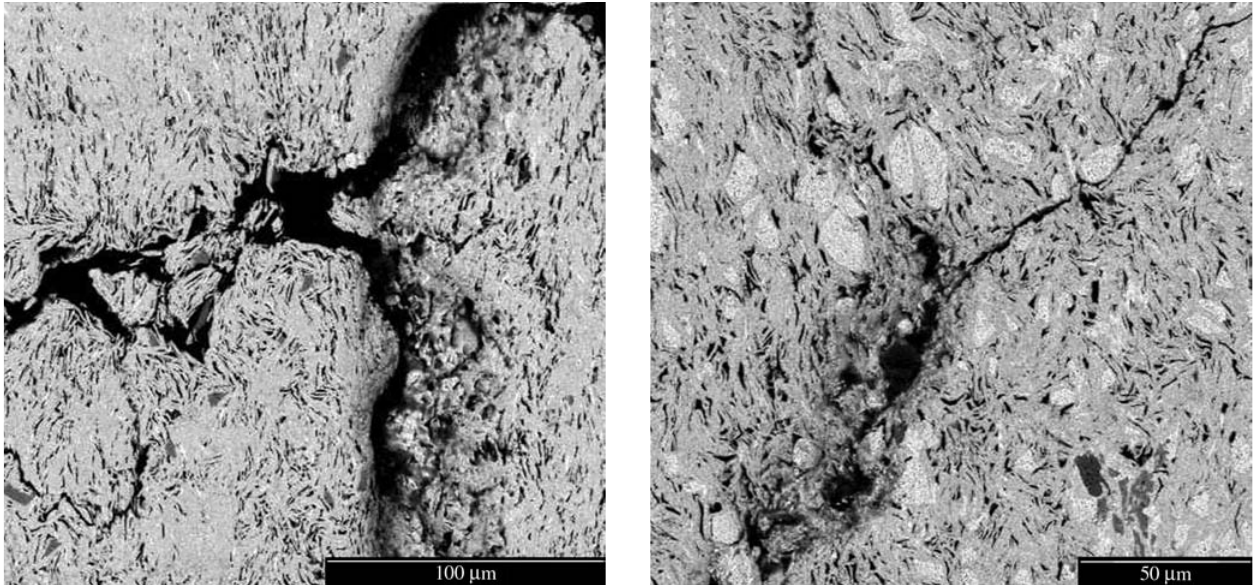
Figure 5. SEM images of the sintered blocks with 0 wt. (%) Ag (left) and 10 wt. (%) Ag (right), showing regions with high porosity, voids and